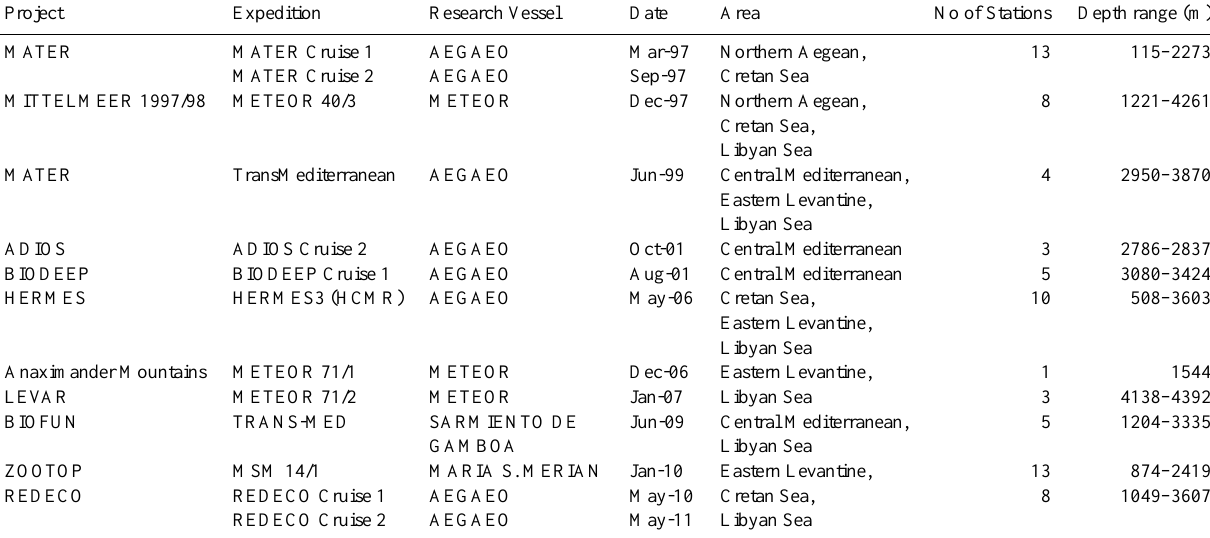
Table 1. Overview of projects, surveys and investigated areas involved in the present study.